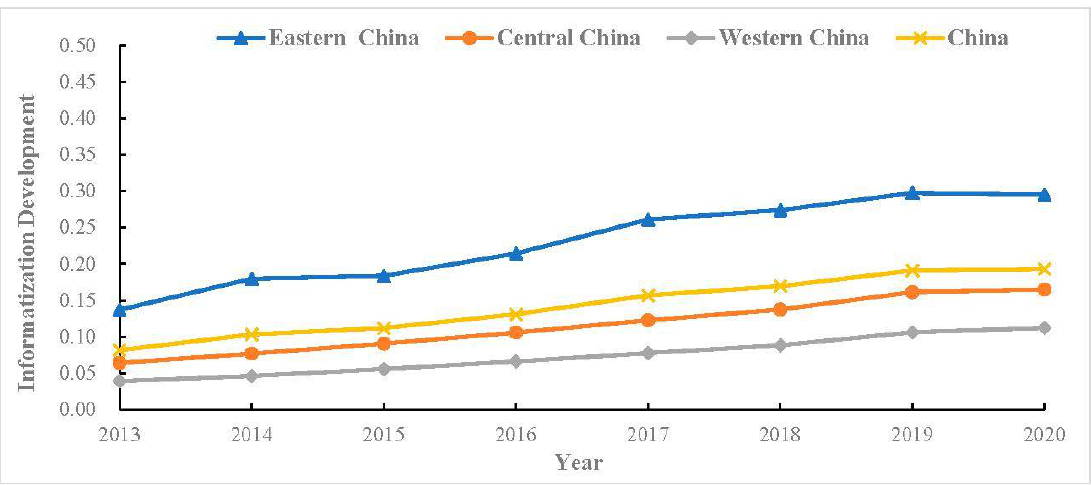
Figure 4. Informatization development in China and three different regions from 2013 to 2020.